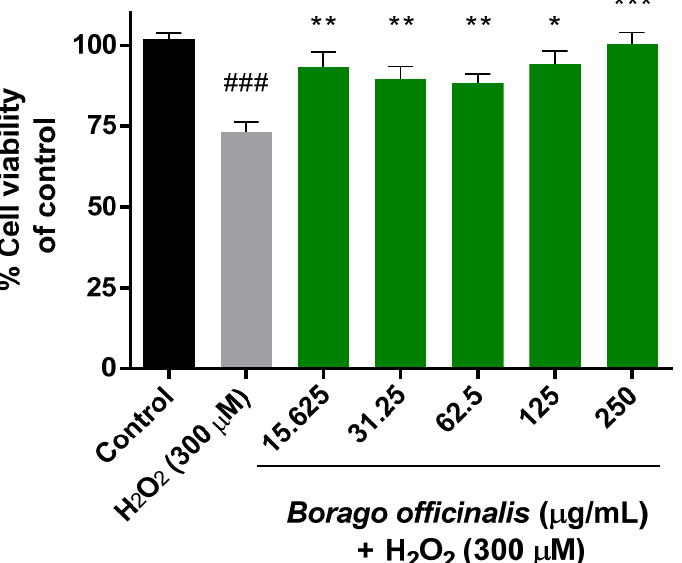
Figure 1. Mitochondrial activity in Neuro-2a cell culture (MTT assay). Cytoprotective effects of Borago officinalis flower extract versus hydrogen peroxide (300 µM). Note: * p < 0.05 versus H 2 O 2 ; ** p < 0.01 versus H 2 O 2 ; *** p < 0.005 versus H 2 O 2 ; ### p < 0.0005 versus control.